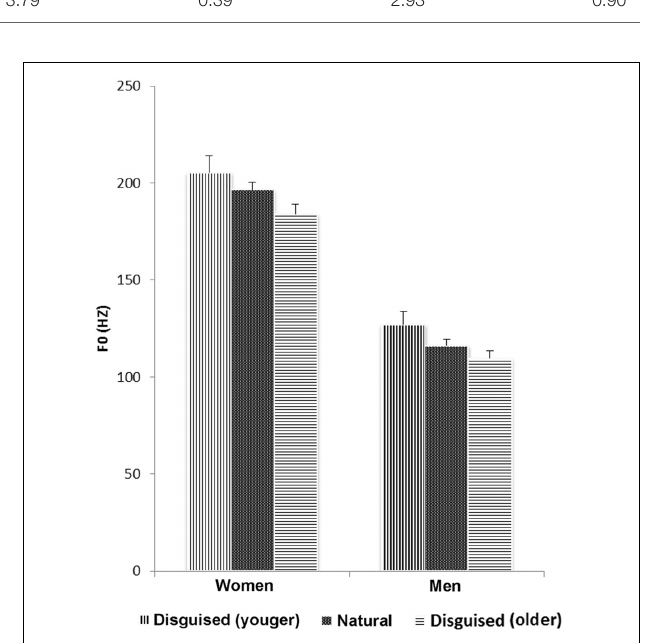
FIGURE 1 | Change in fundamental frequency ( f 0 ) when women and men disguise their voice. Error bars indicate the standard error of the mean (SEM).